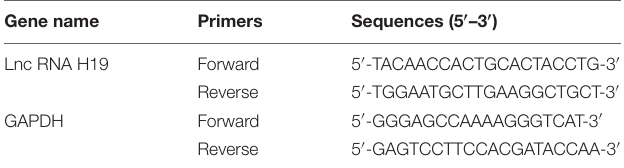
TABLE 1 | Primer sequences used in the study for qPCR